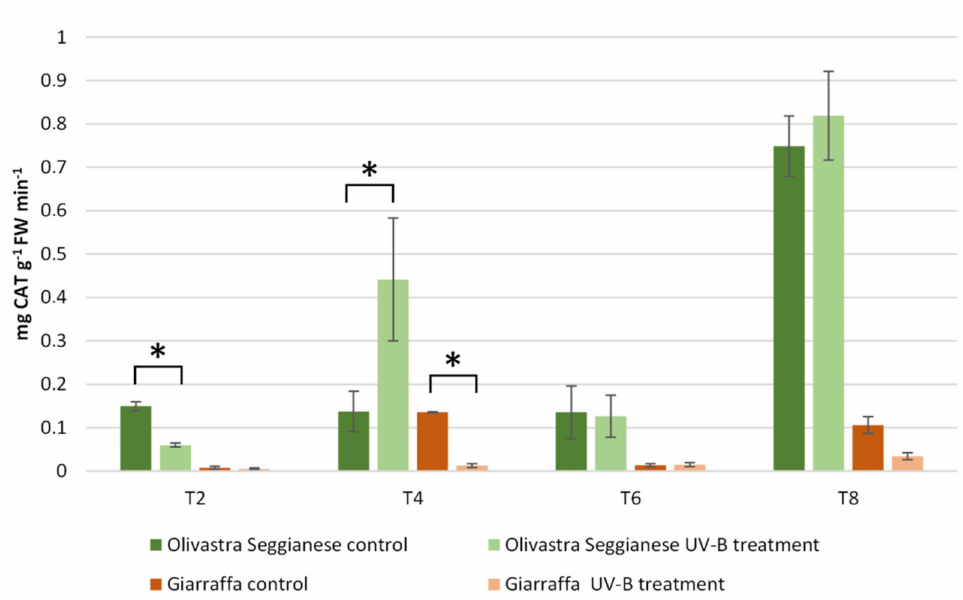
Figure 3. Catalase activity in Giarraffa and Olivastra Seggianese leaves under control conditions and after exposure to UV-B treatment. The X -axis indicates the treatment times. The asterisks (*) indicate statistically significant differences between control and stressed samples within each variety. The two varieties differ by ANOVA test for p ≤ 0.01. Values are mean ± standard ( n = 6).